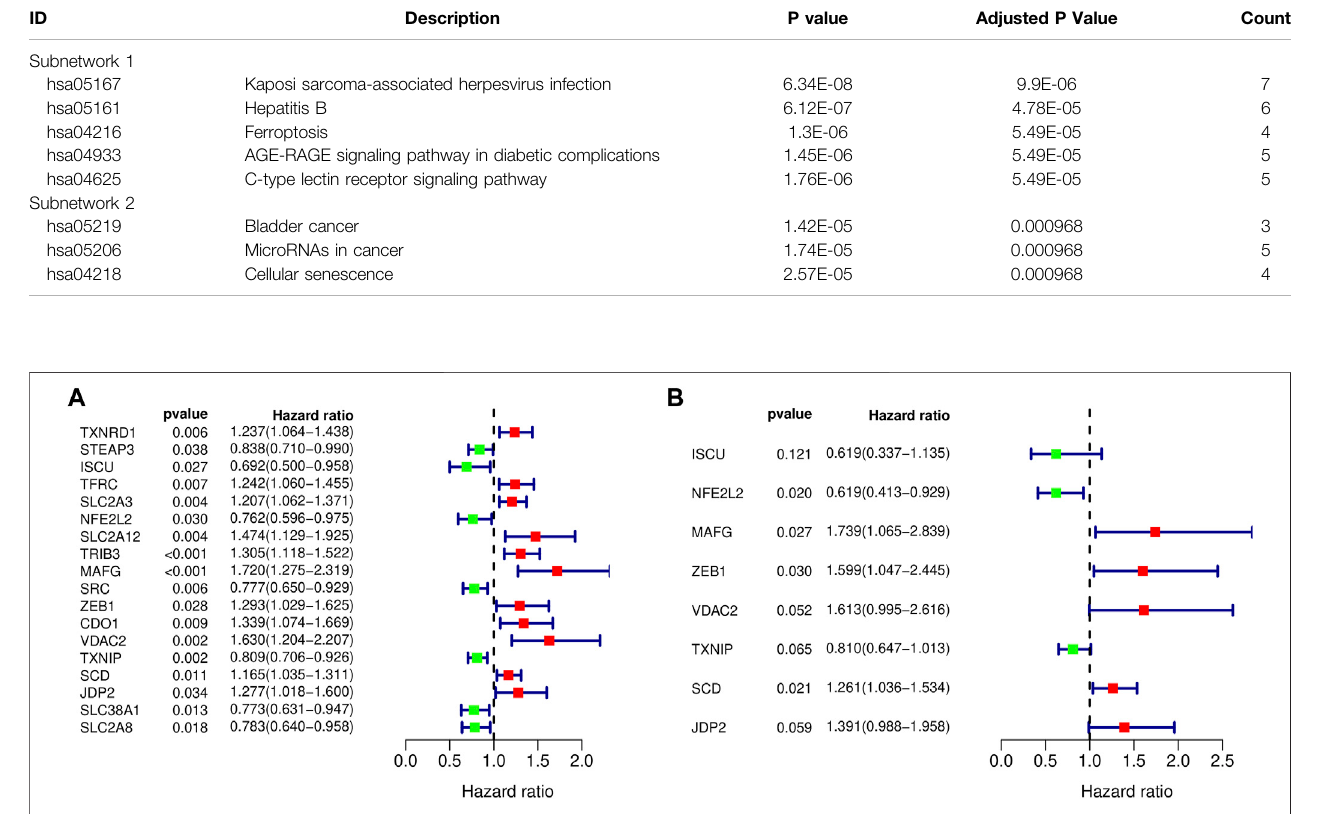
TABLE 3 | The KEGG function enrichment analysis of the two most signi fi cant MCODE components.